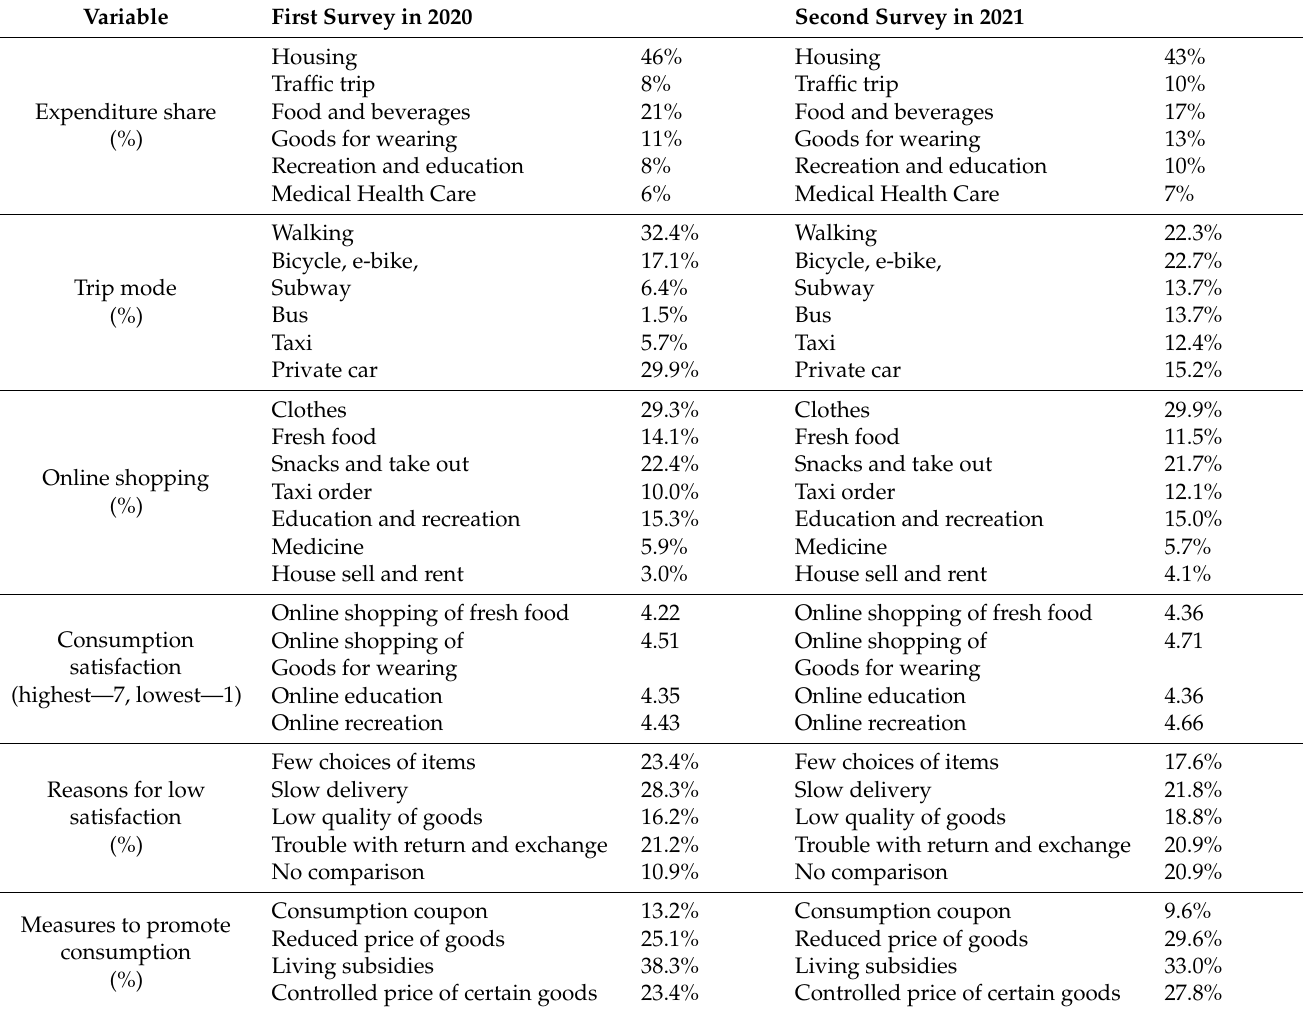
Table 3. Comparison of consumption behaviours during the pandemic in 2020 and in 2021.